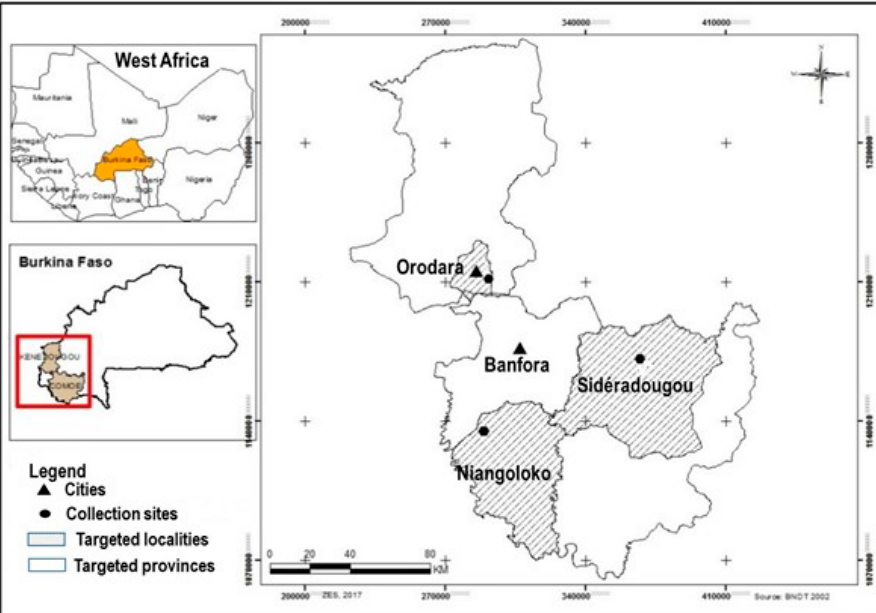
Figure 2. Sampling sites in the Southwest of Burkina Faso [5].